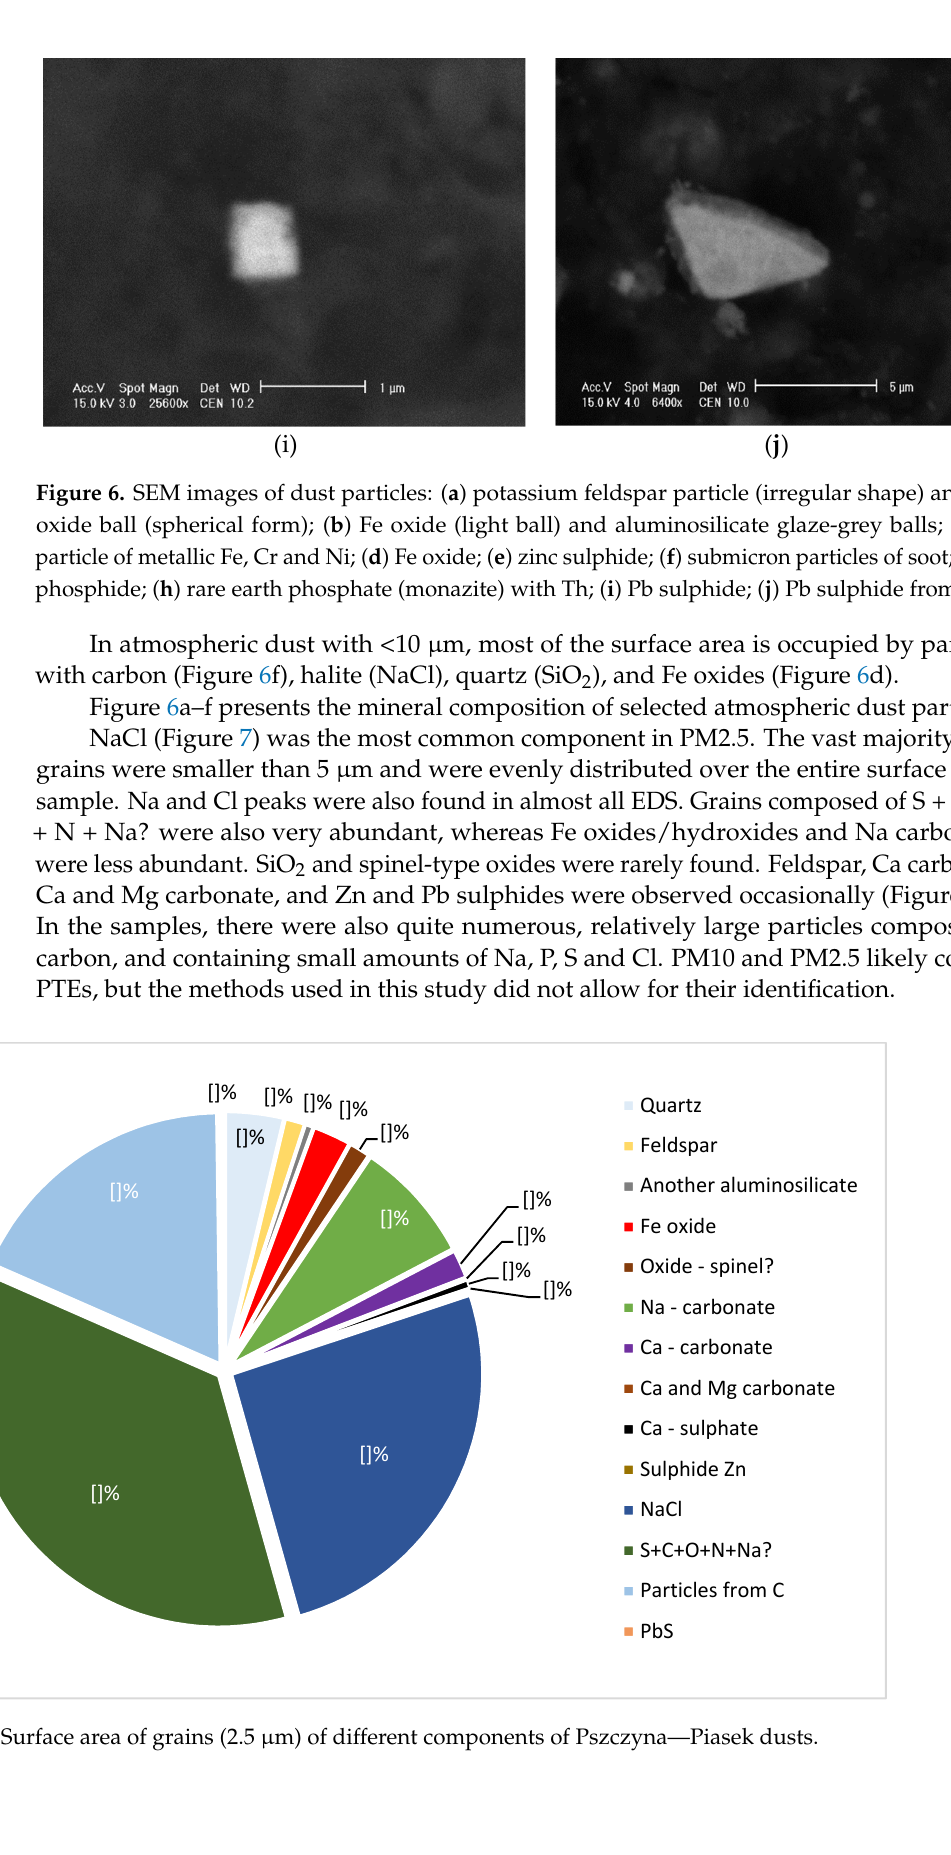
silicate, magnetite, hematite), the PM dust emitted may contain soot, amorphous sele- nium, calcium oxide, crystalline sulphates-anglesite, anhydrite, gypsum and barite [31,33]. Dust emitted into the atmosphere is characterised by highly varied granularity, which is due to the type of coal combustion process in which they are formed and the velocity of the gas that carries them away from their formation site. Table 2 shows the concentration (µg/m 3 ) of the different fractions of atmospheric dust analysed in Pszczyna—Piasek and gives the values of TVOC, TSP and soot. Table 2. Concentrations of PM, TSP, TVOC and soot determined in the winter season in Pszczyna—Piasek. Measurement